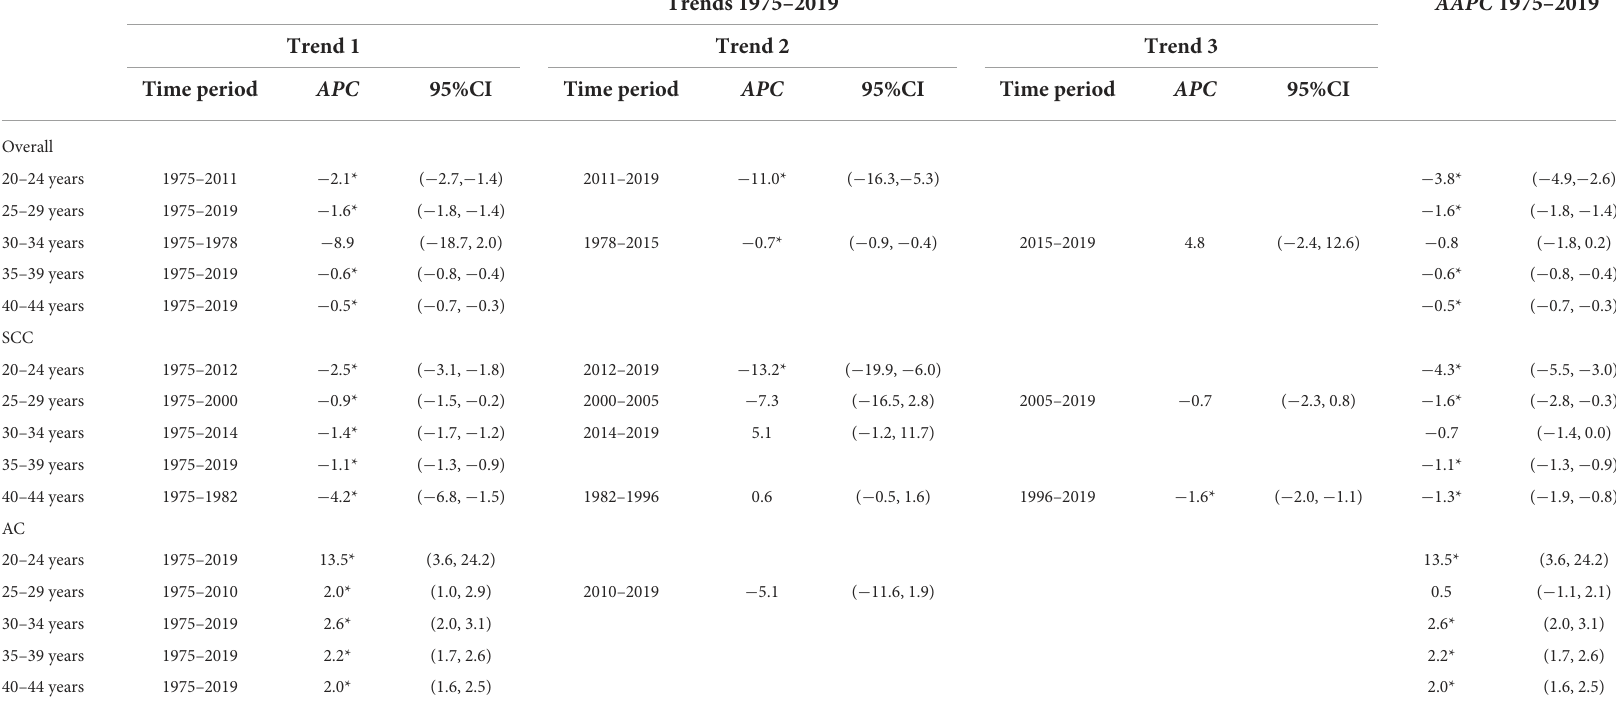
TABLE 3 Trends on cervical cancer incidence rates (1975–2019) for females aged 20–44 years by histology and age, United